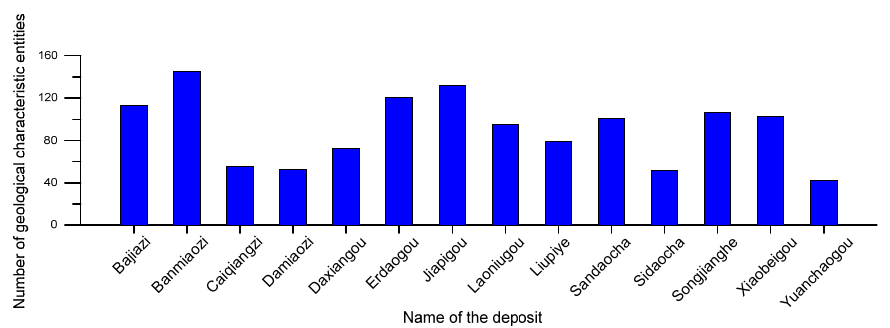
Figure 14. The distribution of the geological characteristic entities in the KG for each deposit.